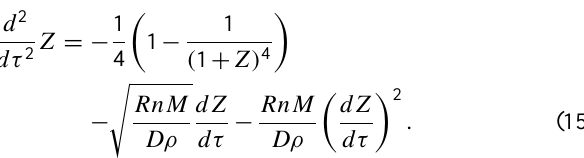
Fig. 8. Variation of plasma density along the line connecting the Sun and the Earth. Distance is normalized also here with the Earth radius R E . This figure serves to define the positions (shown with vertical dashed lines) of the bow shock (left) and the magnetopause (right) as used later on. The density is normalized by the steady state solar wind plasma density. Note the logarithmic vertical axis. Even small variations of the density can give a large change in the local maximum to the right, so motions of this position are not always well